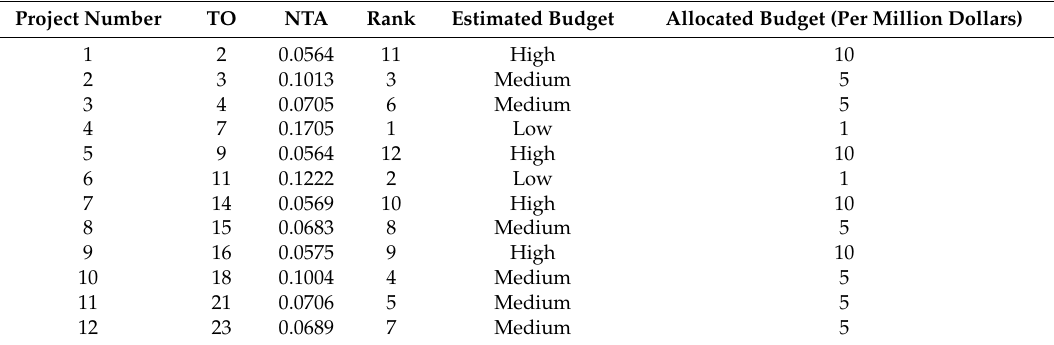
Table 10. Consideration of budget for each